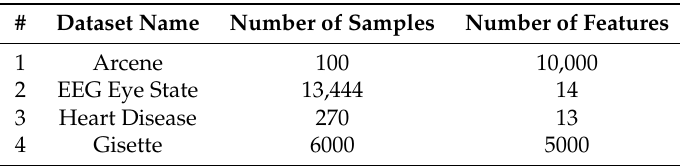
Table 3. Datasets used to evaluate